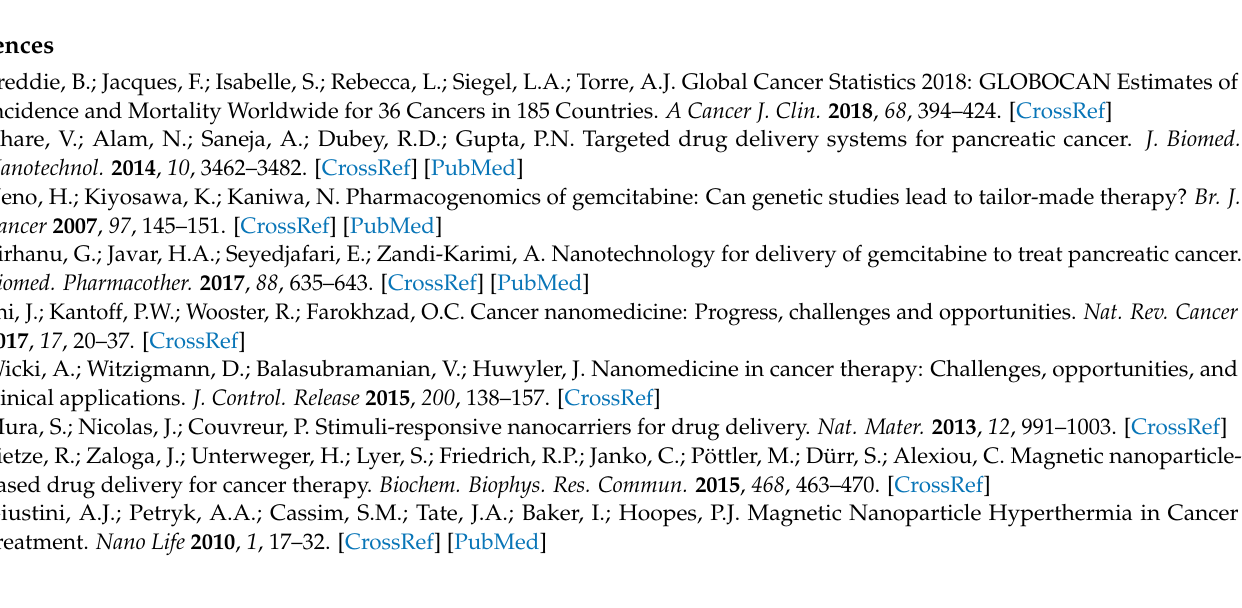
nanoparticles, Table S2: Thermodynamic parameters for the interactions of albumin with MNP and MNP-GEM. Figure S1: General scheme of synthesis of gemcitabine derivative, Figure S2: Hy- drodynamic size evaluation of MNP and MNP-GEM in water, PBS, and DMEM for seven days, Figure S3: Gemcitabine release from MNP-GEM, Figure S4: Stern–Volmer plots of albumin with increasing concentrations of MNP or MNP-GEM nanoparticles at two different temperatures (26.5 ◦ C and 37 ◦ C), Figure S5: Evaluation of magnetic hyperthermia produced by MNP and MNP-GEM, Figure S6: Cell viability assays in PANC-1, BxPC-3, and MiaPaca-2 48 h after treatment, Figure S7: Cell viability assays in HaCaT cells 48 h and 72 h after treatment, Figure S8: Internalization study of MNP and MNP-GEM in BxPC-3 and MiaPaca-2, Figure S9: Nanoparticles internalization in PANC-1, BxPC-3, and MiaPaca-2 in the presence of inhibitors of endocytic pathways, Figure S10: Flow cytometry analysis of apoptosis/necrosis 48 h after treatment in PANC-1, BxPC-3, and MIA Paca-2 cells, Figure S11: Cell viability assays in PANC-1, BxPC-3, and MIA Paca-2 24h after AMF was applied. Figure S12. Calibration line of gemcitabine in PBS. Absorbance measurements at 270 nm in a Synergy H4 microplate